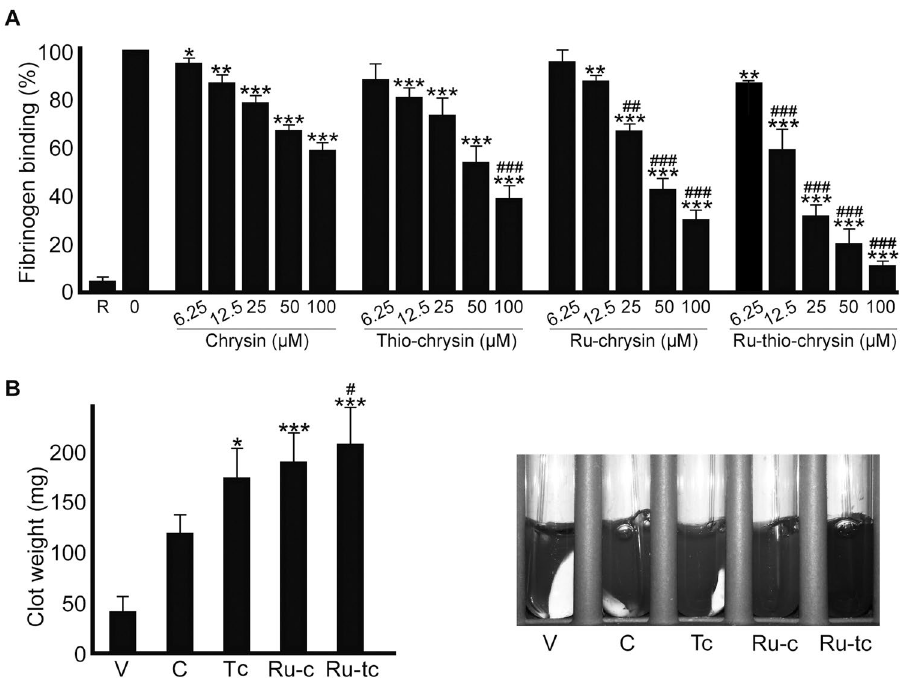
Figure 4. Chrysin and its derivatives inhibit inside-out and outside-in signalling in platelets. ( A ) human platelet-rich plasma was treated with vehicle [0.1% (v/v) DMSO] or diverse concentrations of chrysin, thio- chrysin, Ru-chrysin and Ru-thio-chrysin for 5 minutes prior to the addition of 0.5 μ g/mL CRP-XL and incubation of 20 minutes at room temperature. The level of fibrinogen binding (as a marker for inside-out signalling to integrin α IIb β 3) was quantified using FITC-labelled anti-human fibrinogen antibodies by flow cytometry. The level of fluorescence obtained with vehicle control was taken as 100% to calculate the extent of inhibition in chrysin and its derivatives-treated samples. R represents ‘resting’ platelets. Cumulative data represent mean ± S.D. (n = 4). ( B ) human platelet-rich plasma was treated with vehicle (V) [0.1% (v/v) DMSO] or 50 μ M of chrysin (C) or its derivatives, thio-chrysin (Tc), Ru-chrysin (Ru-c) and Ru-thio-chrysin (Ru-tc) for 5 minutes. Following incubation, clotting was initiated by the addition of 1 U/mL thrombin and the clot retraction was monitored for three hours. The remaining clot weight at three hours was measured to analyse the extent of retraction process. The image shown on the right is representative of four separate experiments. * Indicates significance with respect to controls and # indicates significance with respect to the respective chrysin concentrations; p values shown ( * ,# p < 0.05, ** ,## p < 0.01 and *** ,### p < 0.001) are as calculated by one-way ANOVA using Graphpad